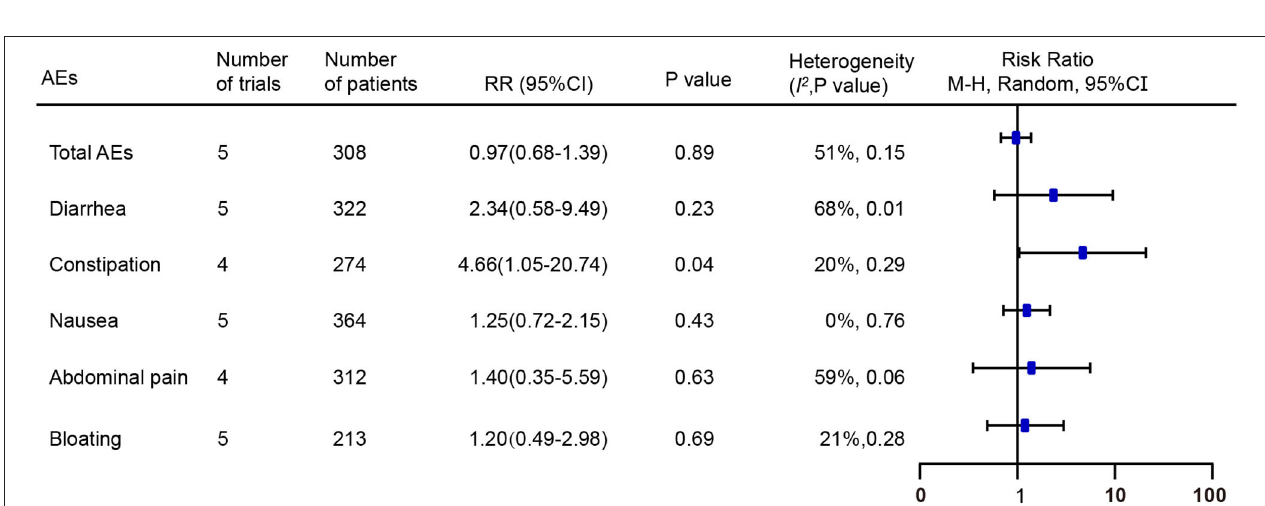
FIGURE 5 | Forest plot of the effect of FMT on IBS-SSS and IBS-QOL. (A) Forest plot of the effect of FMT on IBS-SSS compared with placebo; (B) Forest plot of the effect of FMT on IBS-QOL compared with placebo.